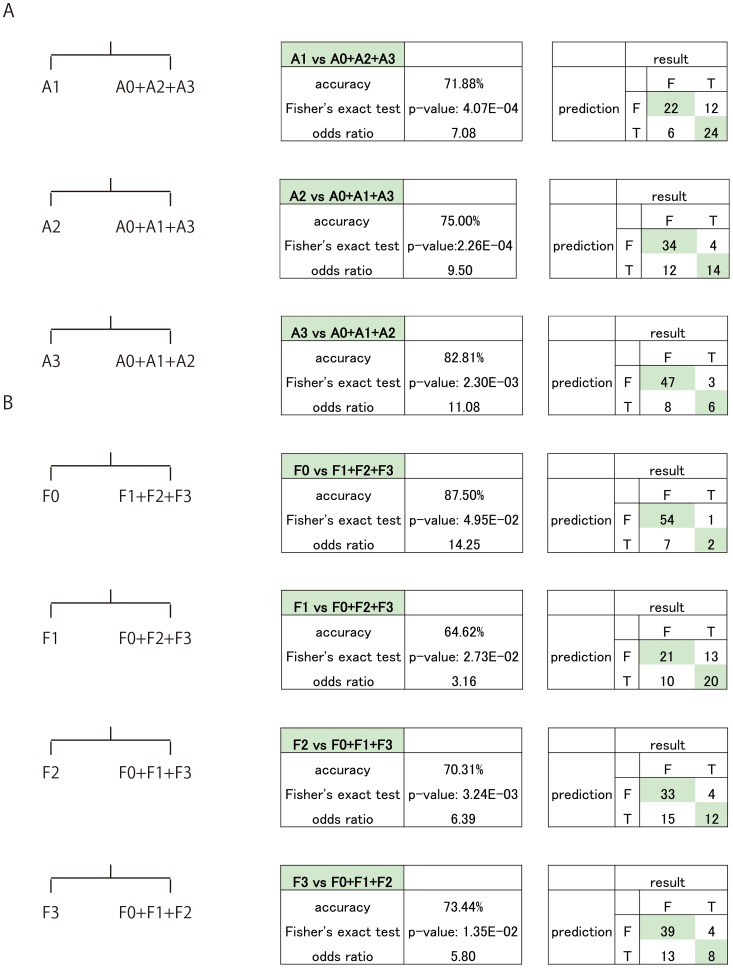
Determining liver inflammation grade and fibrotic stage using miRNA expression pattern in LOOCV analysis.A. In order to diagnose the grade of liver inflammation, A0 was identified first. Next A1, A2, and A3 were identified in a similar manner as A0. For each, the accuracy rate, P value, and the odds ratio are shown. B. For liver fibrosis stage, F0 was first diagnosed following which the other stages F1, F2, and F3 were diagnosed in a similar manner. For each group the accuracy rate, P value, and the odds ratio are shown.